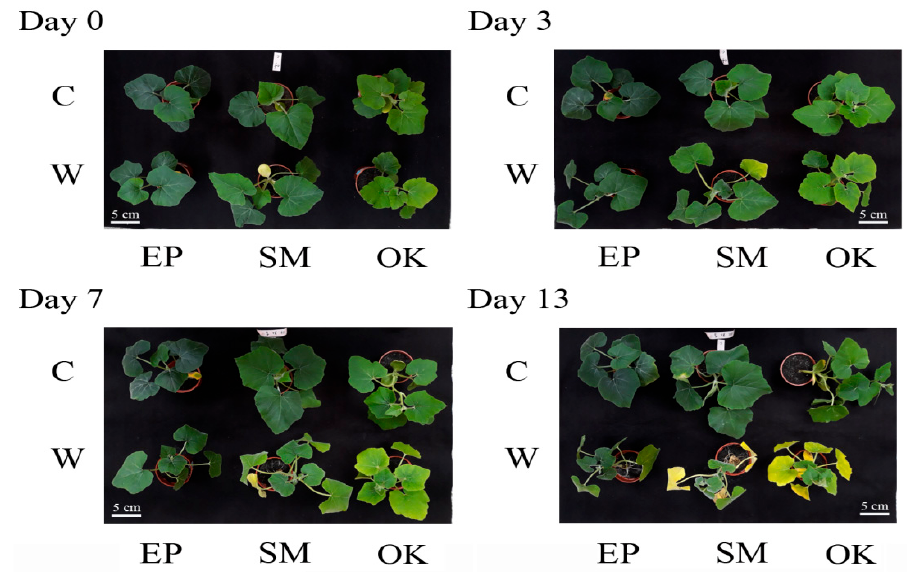
Figure 1. Appearance of EP, SM, and OK squash plants grown under optimally irrigated (control, C) or waterlogging (W) conditions for 0 (non-waterlogging), 3, 7, and 13 d periods. Bar indicates 5 cm.